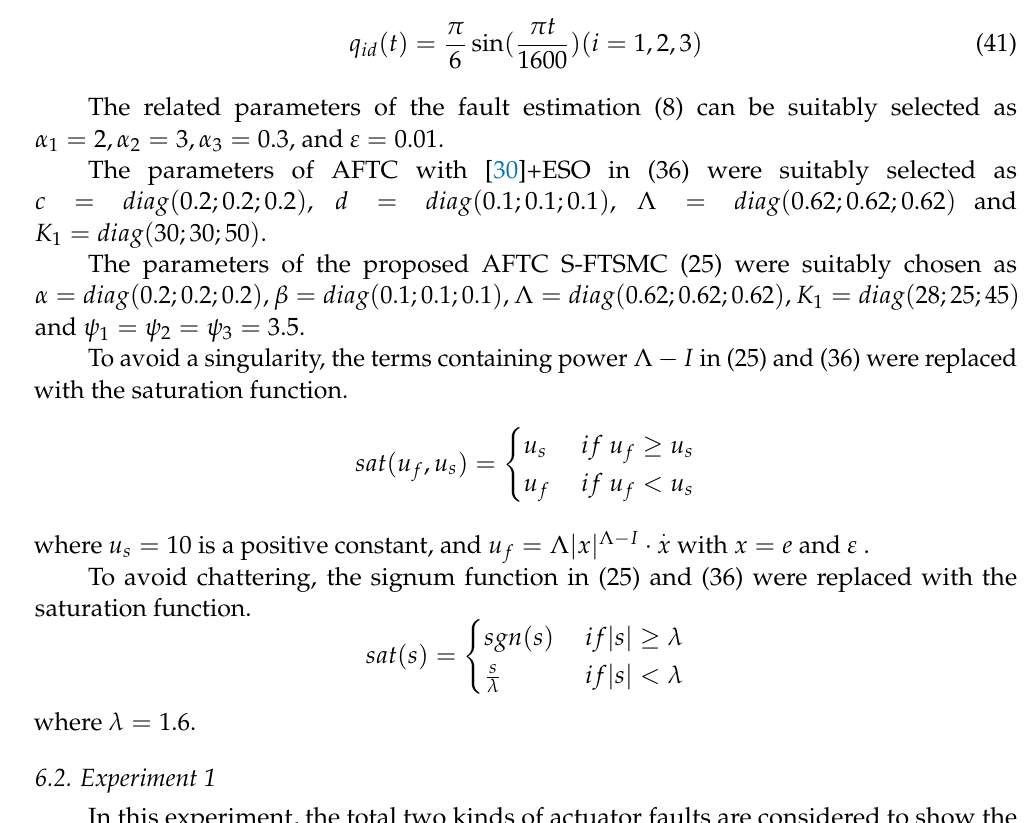
Figure 6. Experiment setup for 3-DOF FARA-AT2 robot manipulator.